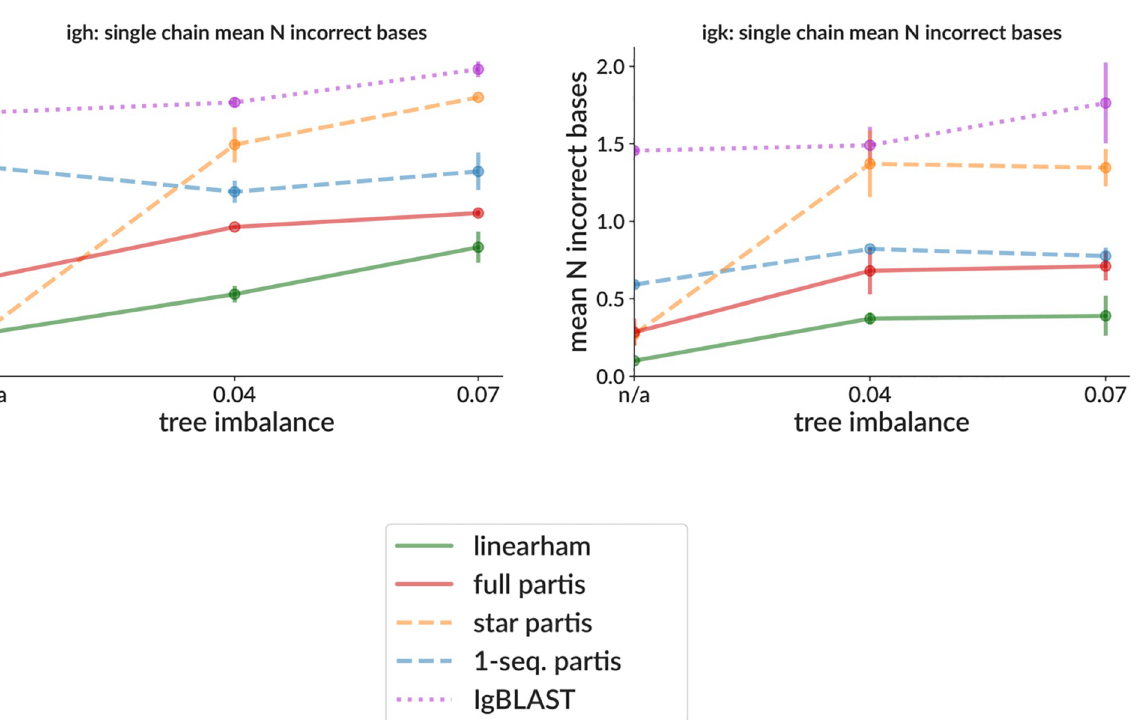
PLOS Computational Biology | https://doi.org/10.1371/journal.pcbi.1010723 November 28,